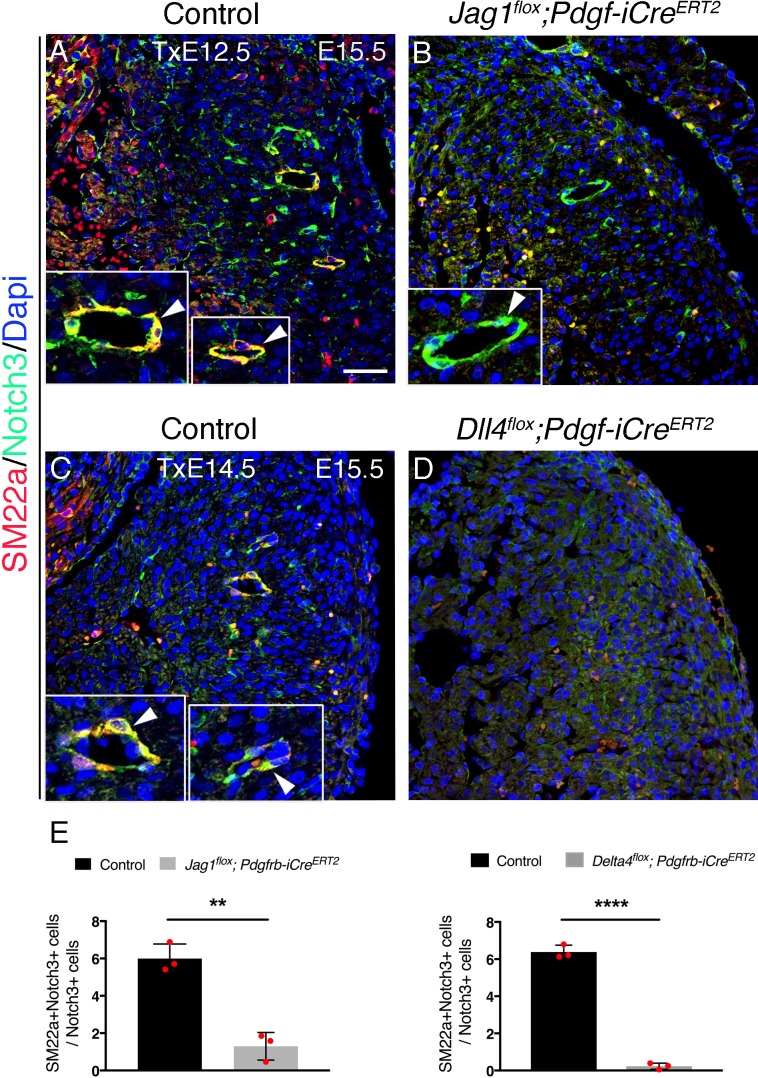
Induced endothelial Jag1 or Dll4 deletion disrupts coronary smooth muscle cell differentiation.(A) Immunofluorescence for SM22a (red) and Notch3 (green) on sections of E15.5 control, and Jag1flox;Pdgfb-iCreERT2 and Dll4flox;Pdgfb-iCreERT2 mutants tamoxifen-induced at E12.5 and E14.5 respectively. Dapi counterstain (blue). Inserts, magnification of larger coronary arteries. Arrowheads point to larger arteries that are both SM22a and Notch3-positive in control and SM22a-negative/Notch3-positive in the Jag1flox;Pdgfb-iCreERT2 mutant. Coronaries are altogether absent in the Dll4flox;Pdgfb-iCreERT2 mutant. Microscope: Nikon A1-R. Software: NIS Elements AR 4.30.02. Build 1053 LO, 64 bits. Objectives: Plan Apo VC 20x/0,75 DIC N2 dry; Plan Fluor 40x/1,3 Oil DIC H N2 Oil. (B) Quantified data from E15.5 control, and Jag1flox;Nfatc1-Cre and Dll4flox;Nfatc-Cre mutants. Data are mean of ± s.d. (n = 3 controls and three mutants). **p<0.01, ****p<0.0001 by Student's t-test. Scale bar, 100 µm.